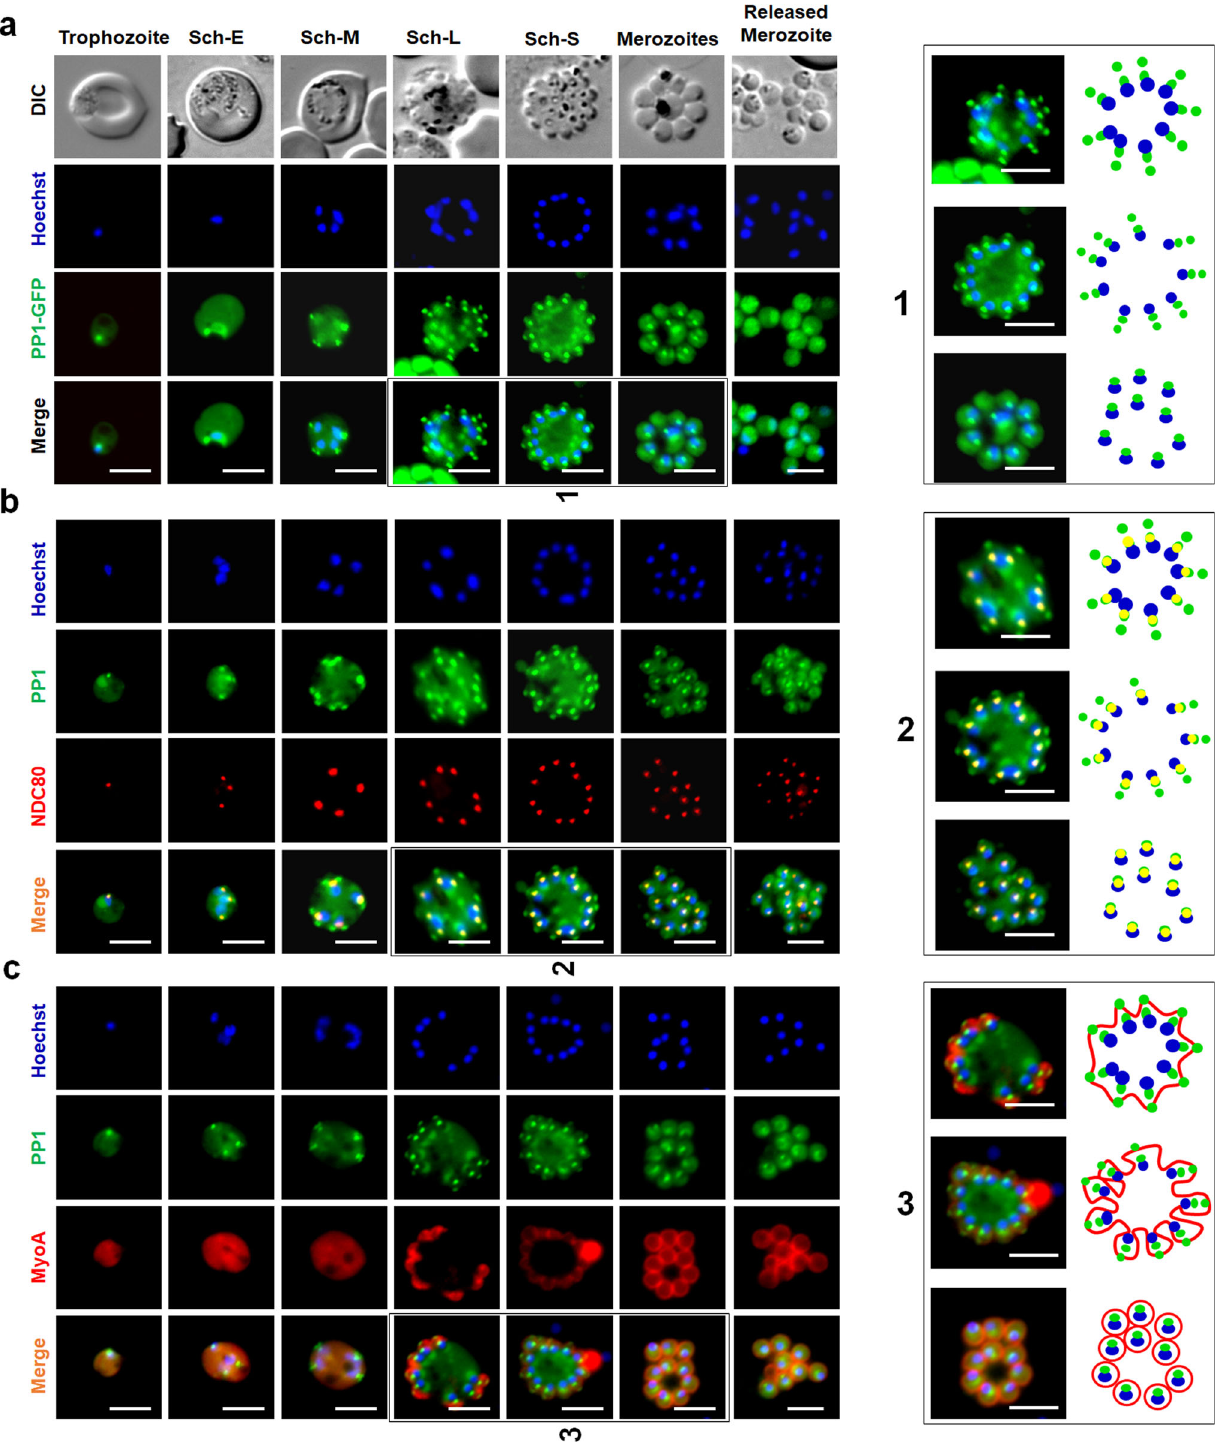
Fig. 1 Location of PP1 during asexual blood stage schizogony and its association with kinetochore (NDC80) and glideosome (MyosinA). a Live-cell imaging of PP1-GFP (Green) showing its location during different stages of intraerythrocytic development and in free merozoites. DIC differential interference contrast, Hoechst stained DNA (blue), Merge green and blue images merged. A schematic guide showing the locations of PP1GFP foci during segmentation of merozoites is depicted in right-hand panel. b Live-cell imaging showing location of PP1 – GFP (green) in relation to the kinetochore marker NDC80-mCherry (red) and DNA (Hoechst, blue). Merge: green, red and blue images merged. A schematic guide showing the locations of PP1GFP foci with NDC80-mCherry during segmentation of merozoites is depicted in right-hand panel. c Live imaging showing the location of PP1 – GFP (green) in relation to inner membrane complex marker MyoA-mCherry (red) and DNA (Hoechst, blue) during different stages of intraerythrocytic development and in extracellular merozoites. A schematic guide showing the locations of PP1GFP foci with MyoA-mCherry during segmentation of merozoites is depicted in the three right-hand panels. Merge: green, red and blue images merged. Sch-E (Early schizont), Sch-M (Middle schizont), Sch-L (Late schizont) and Sch-S (Segmented schizont). In all panels, scale bar = 5 µ